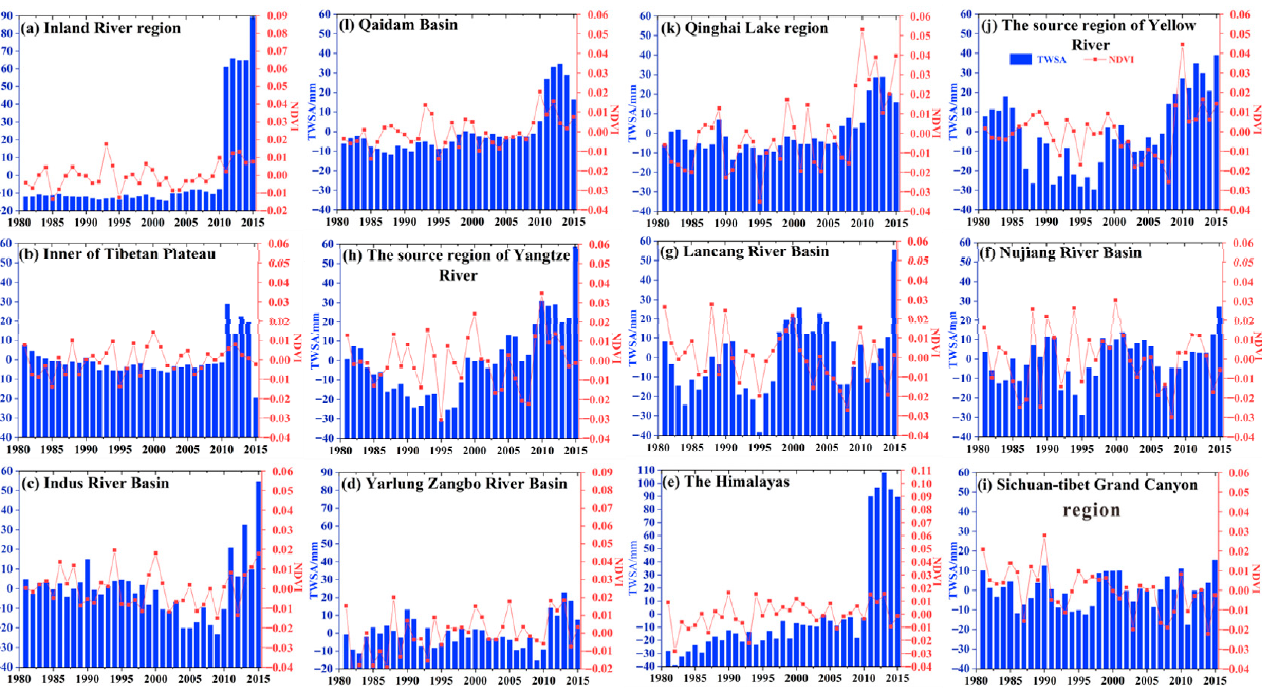
Figure 13. Temporal trend in terrestrial water storage anomaly and NDVI for each sub-region over the Tibetan Plateau during the period 1981–2015.